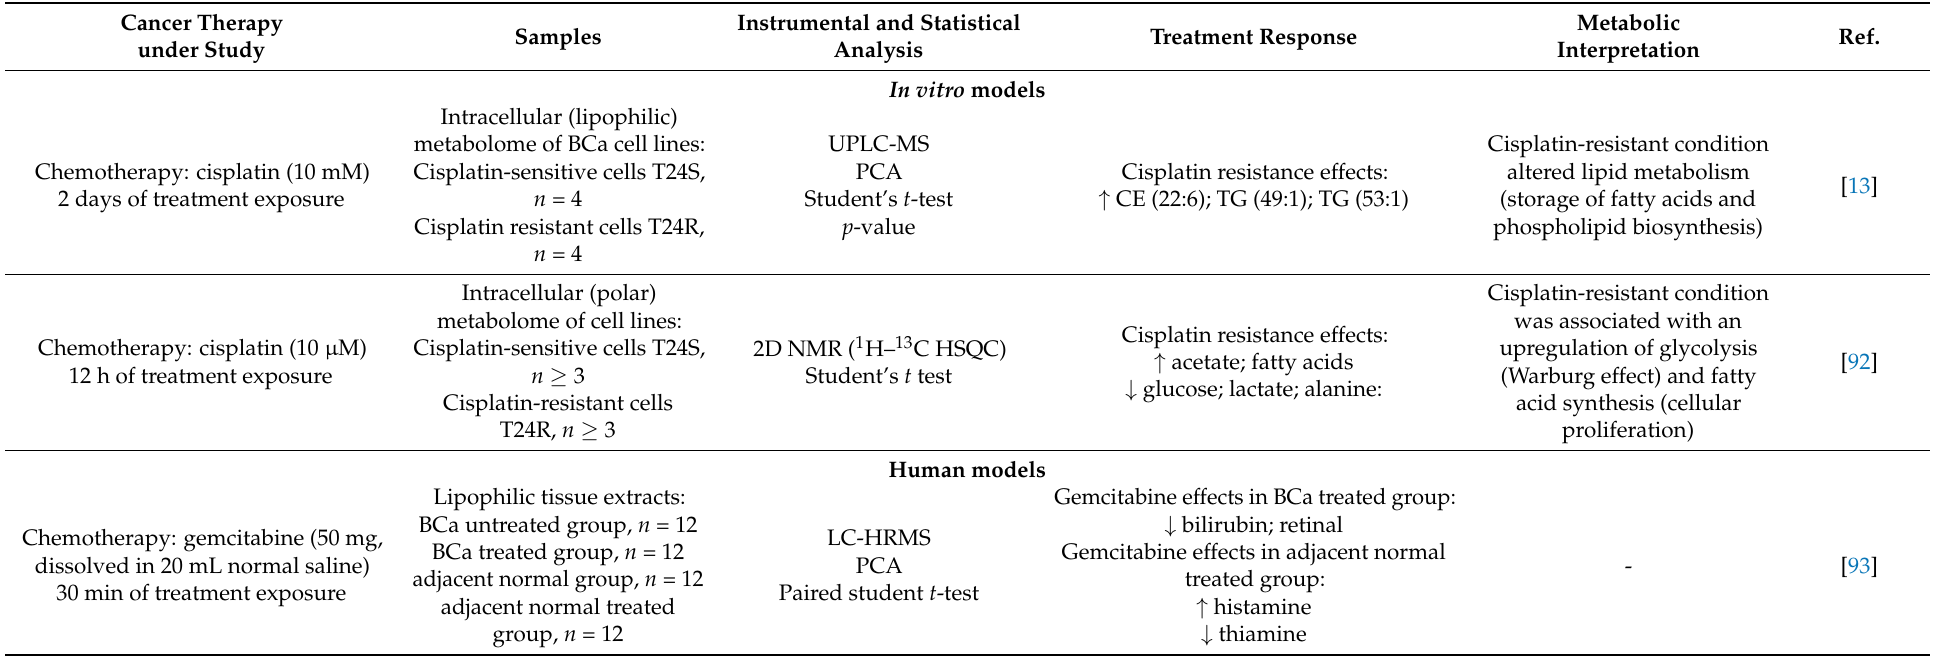
Table 2. Pharmacometabolomic studies performed in